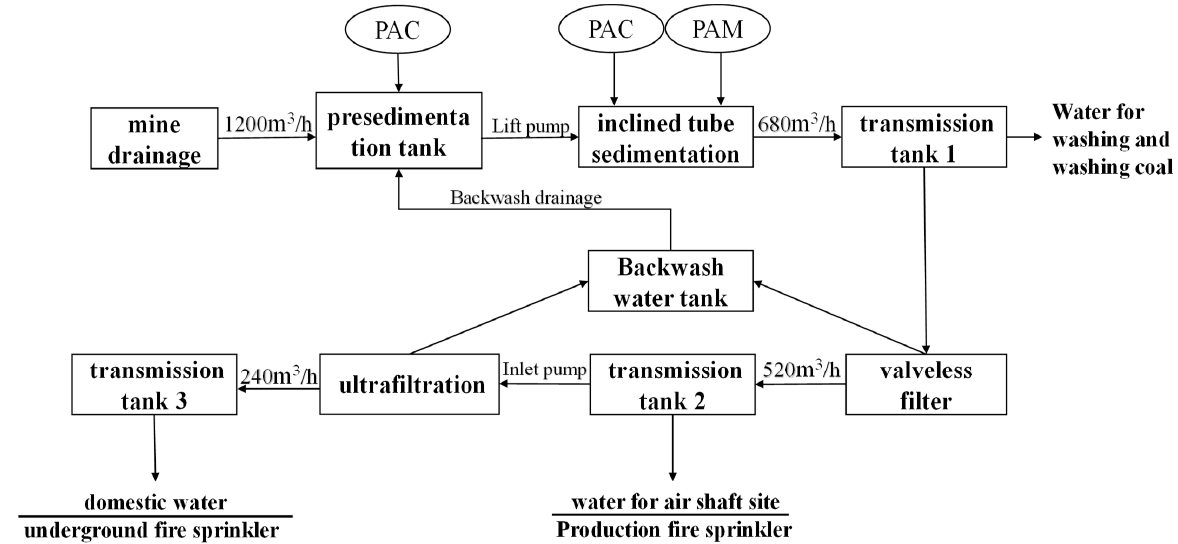
Figure 3. Process flowchart of mine water treatment in the Caojiatan coal mine.